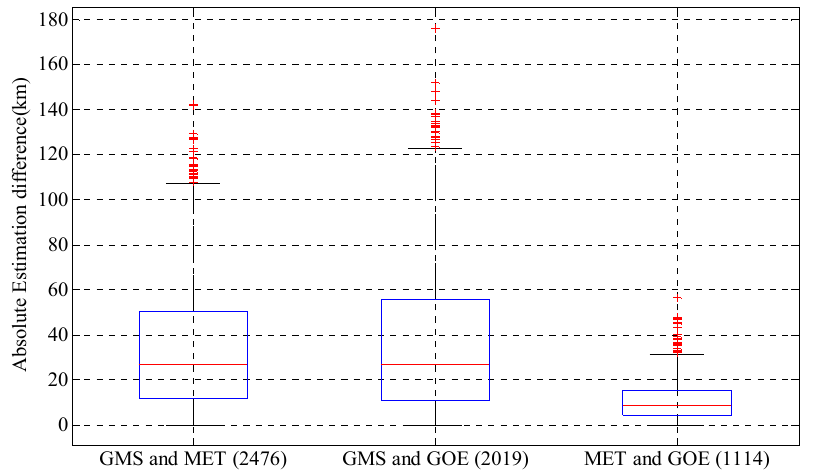
Figure 4. Comparison of estimation of TC size (each group represents the absolute difference between the estimates from two different satellites. The definition of the boxes is the same as in Figure 3).